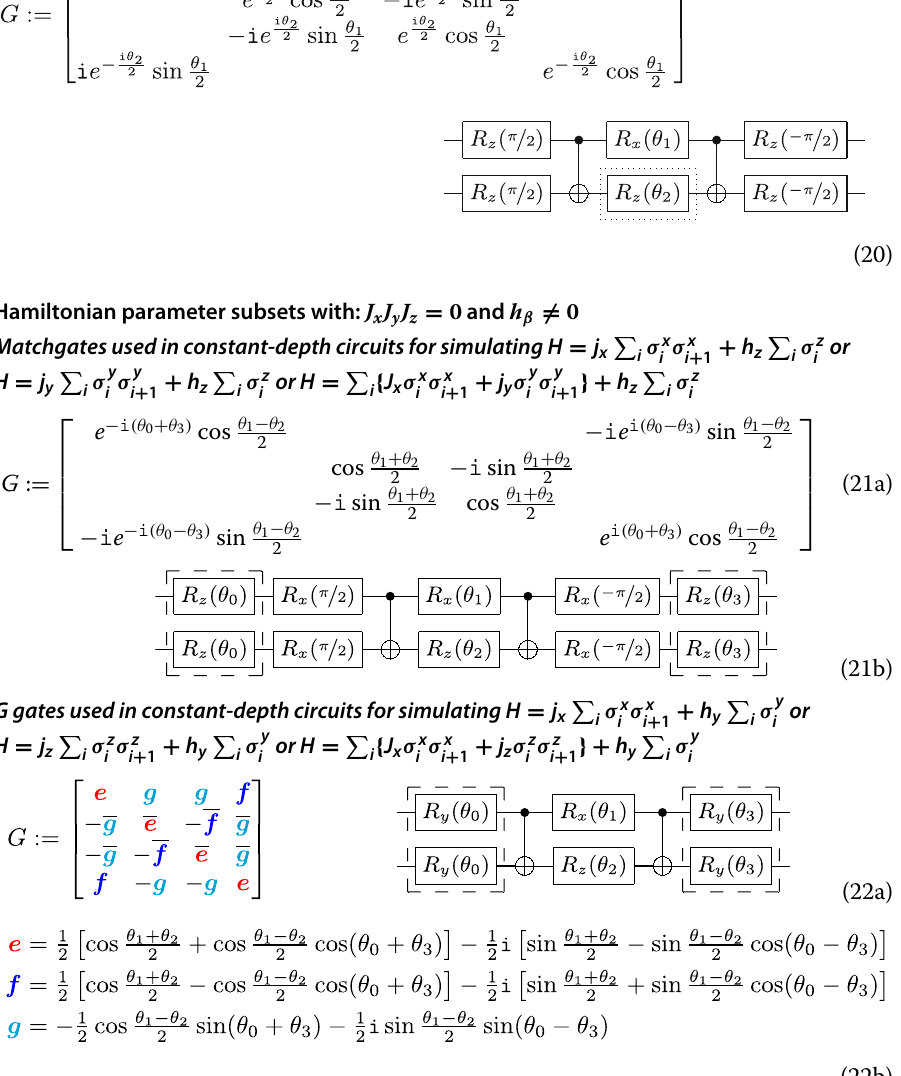
Hamiltonian parameter subsets with: J x J y J z = 0 and h β (cid:2)= 0 Matchgates used in constant-depth circuits for simulating H = j x